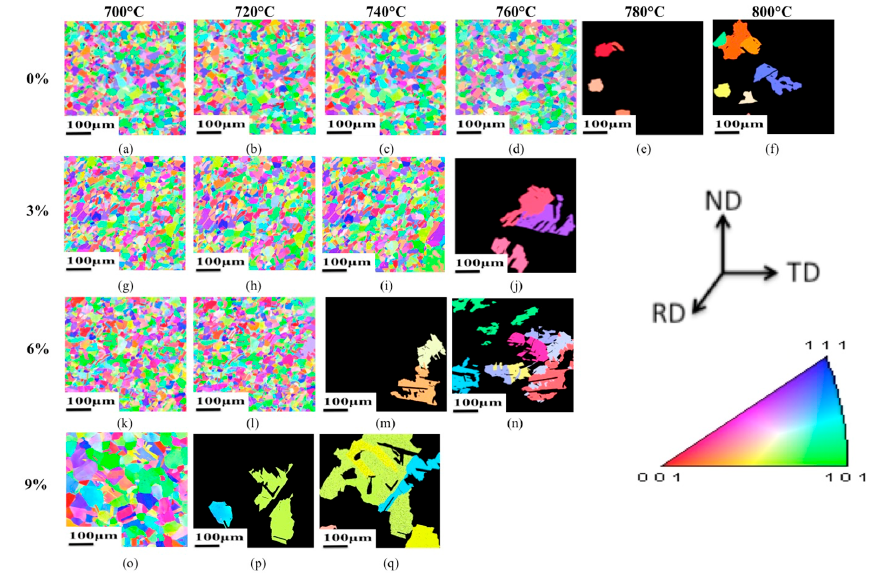
Figure 6. AGG (abnormal grain growth) identification progression maps for 0% ( a – f ), 3% ( g – j ), 6% ( k – n ), and 9% ( o – q ) induced strain following annealing treatments ranging from 700 °C to 800 °C. (Orientation is shown with respect to the rolling direction (RD); Adapted with permission from [19], © 2016 ASM International and Springer Science + Business Media New York, 2016.)